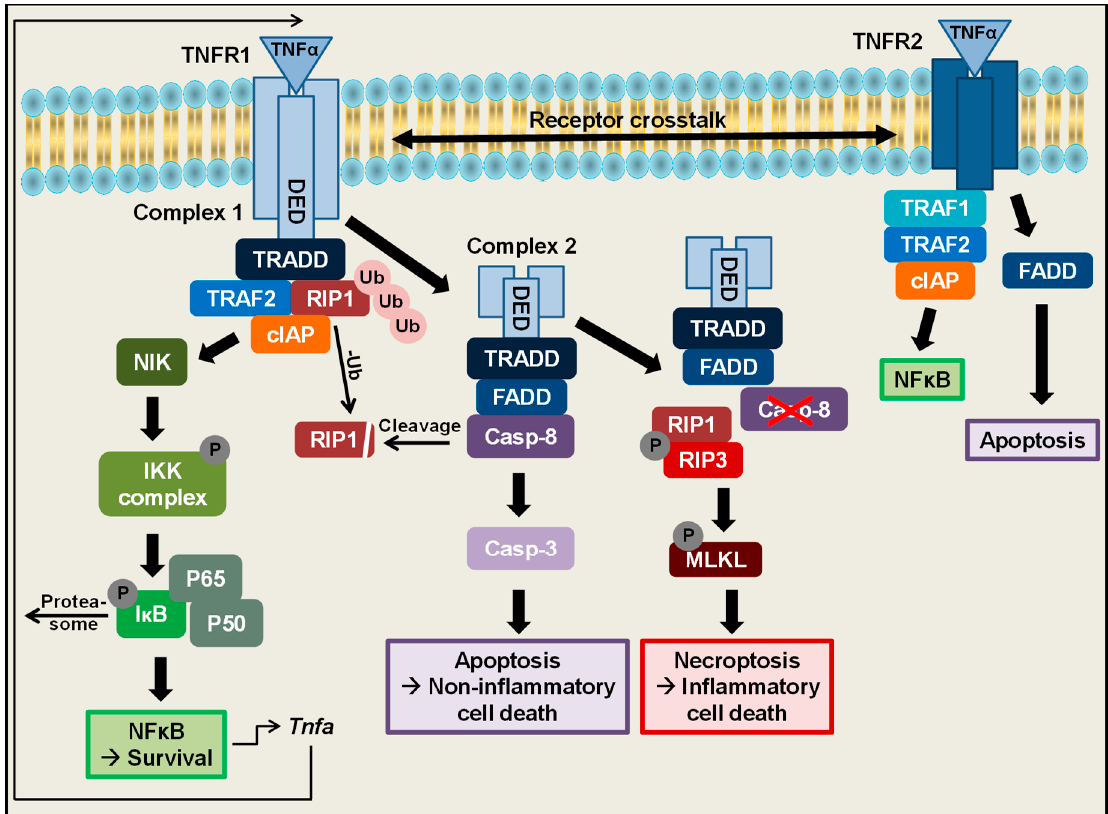
Figure 1. Regulation of cell death and survival by tumour necrosis factor alpha (TNF α ). Binding of TNF α to TNFR1 leads to receptor trimerization and formation of receptor complex 1. This complex consists of TRADD, TRAF2, polyubiquitinylated RIP1 and cIAP and mediates cell survival via activation of NF κ B. TNFA gene expression itself is regulated by NF κ B. Depending on the cellular context, TNF α binding to TNFR1 can lead to formation of receptor complex 2, consisting of TRADD, FADD, deubiquitinylated RIP1 and Caspase-8. Activated caspase-8 cleaves RIP1 and further initiates a downstream caspase cascade to trigger apoptotic cell death, which is regarded as a non-inflammatory type of cell death. If caspase-8 activity is blocked, RIP1 cannot be cleaved anymore, leading to heterodimerization with RIP3 and autophosphorylation. Subsequently, RIP3 phosphorylates and activates MLKL, which oligomerizes, translocates to the cell membrane and initiates pore formation to induce necroptosis, which is described as a rather inflammatory type of cell death. In addition, depending on the cellular conditions binding of TNF α to TNFR2 can induce NF κ B signalling or apoptosis, either independently or dependent on TNFR1 signalling via receptor crosstalk.